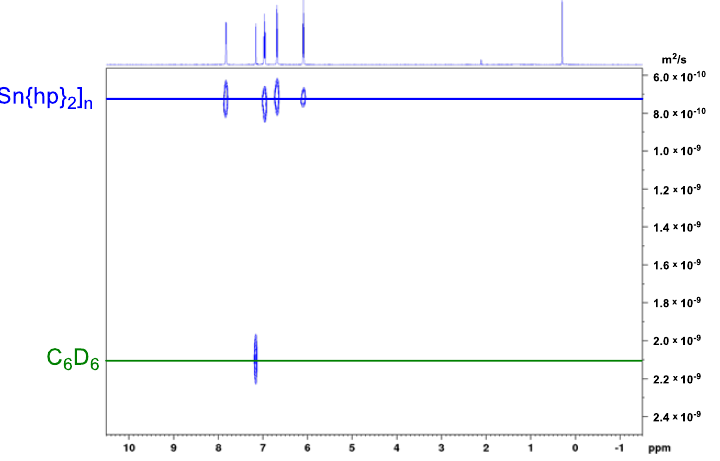
Figure 3. Plot showing the 1 H DOSY NMR spectrum for compound 2 (298 K).